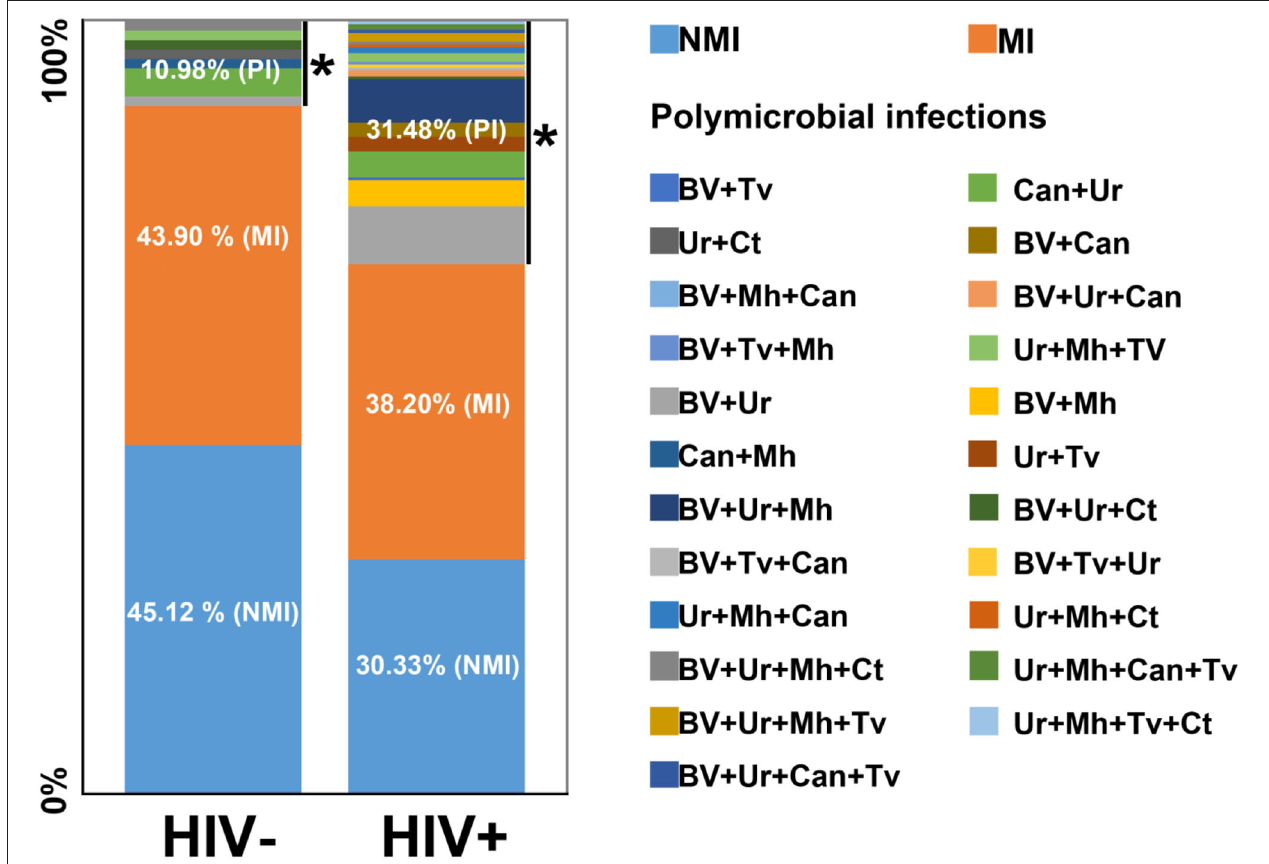
FIGURE 1 | Distribution of infections in both HIV– and HIV + populations. Tv, Trichomonas vaginalis ; BV, bacterial vaginosis; Ur, Ureaplasma sp; Mh, Mycoplasma hominis; Can, Candidiasis; Ct, Chlamydia trachomatis ; MI, monomicrobial infection; NMI, no microbial infection; PI, polymicrobial infection. *Statistically significant ( p < 0.05). OR: 3.85, confidence interval